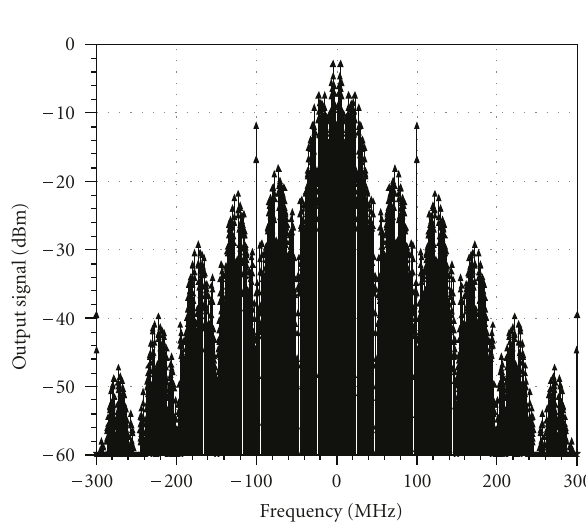
Figure 11: Typical spectrum of a baseband quadrature signal.